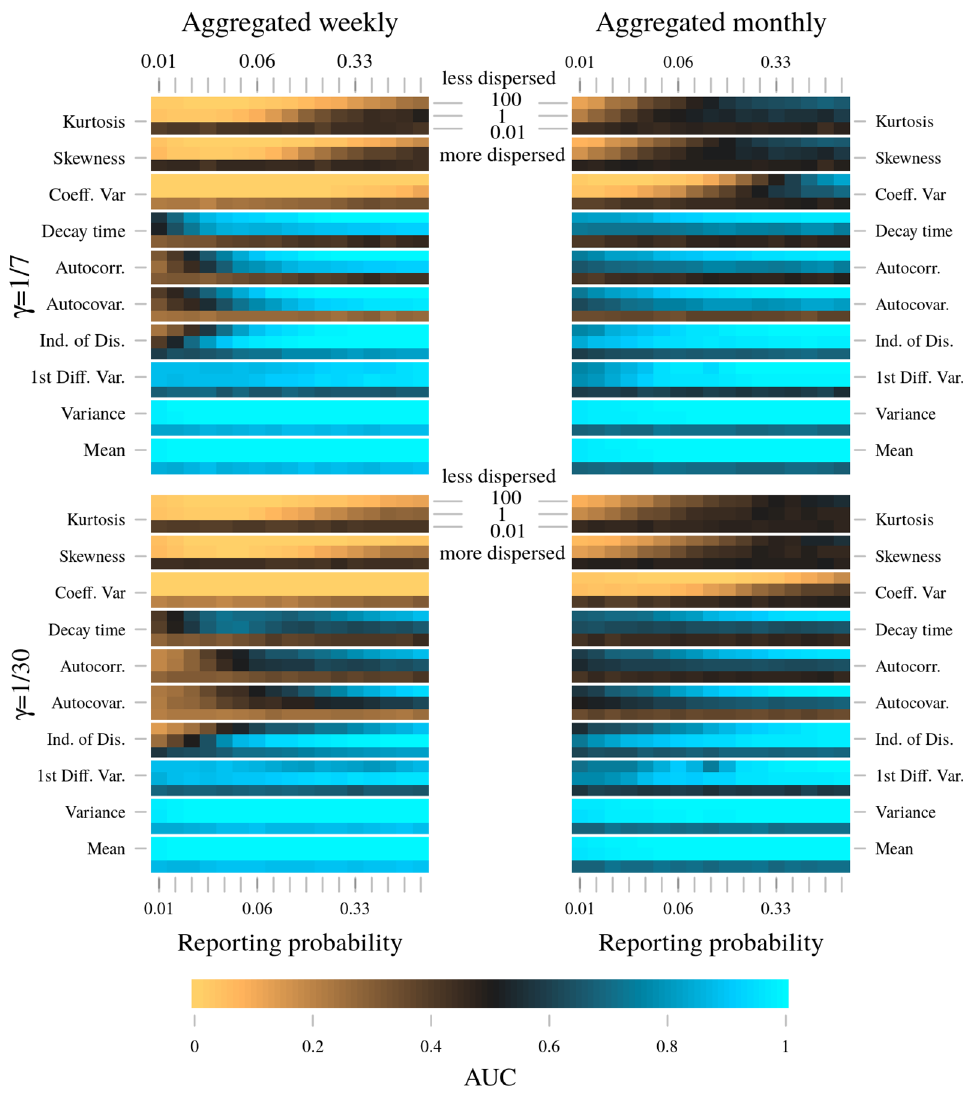
Fig 5. Heat maps showing impact of reporting process parameters and infectious period on performance of EWS. AUC values further from 0.5 imply better performance. For each reporting scenario, 1000 20 year long replicates of both the test (emerging) and null (stationary) SIR model are simulated using the Gillespie algorithm, for fixed model parameters see Methods. All EWS are then calculated for each replicate. To quantify ability to identify emergence, AUC values are calculated from the distributions of the rank correlation coefficient for each EWS, see Methods. The scales for both the overdispersion and reporting probability are logarithmic.